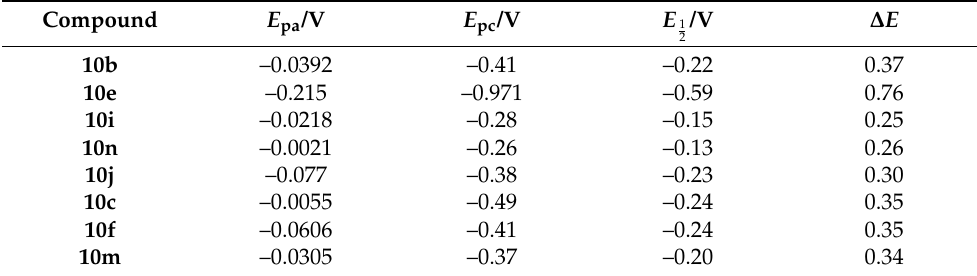
Table 2 . Redox potentials (V vs. Ag/Ag+) of selected riminophenazines. Table 2. Redox potentials (V vs. Ag/Ag+) of selected riminophenazines.